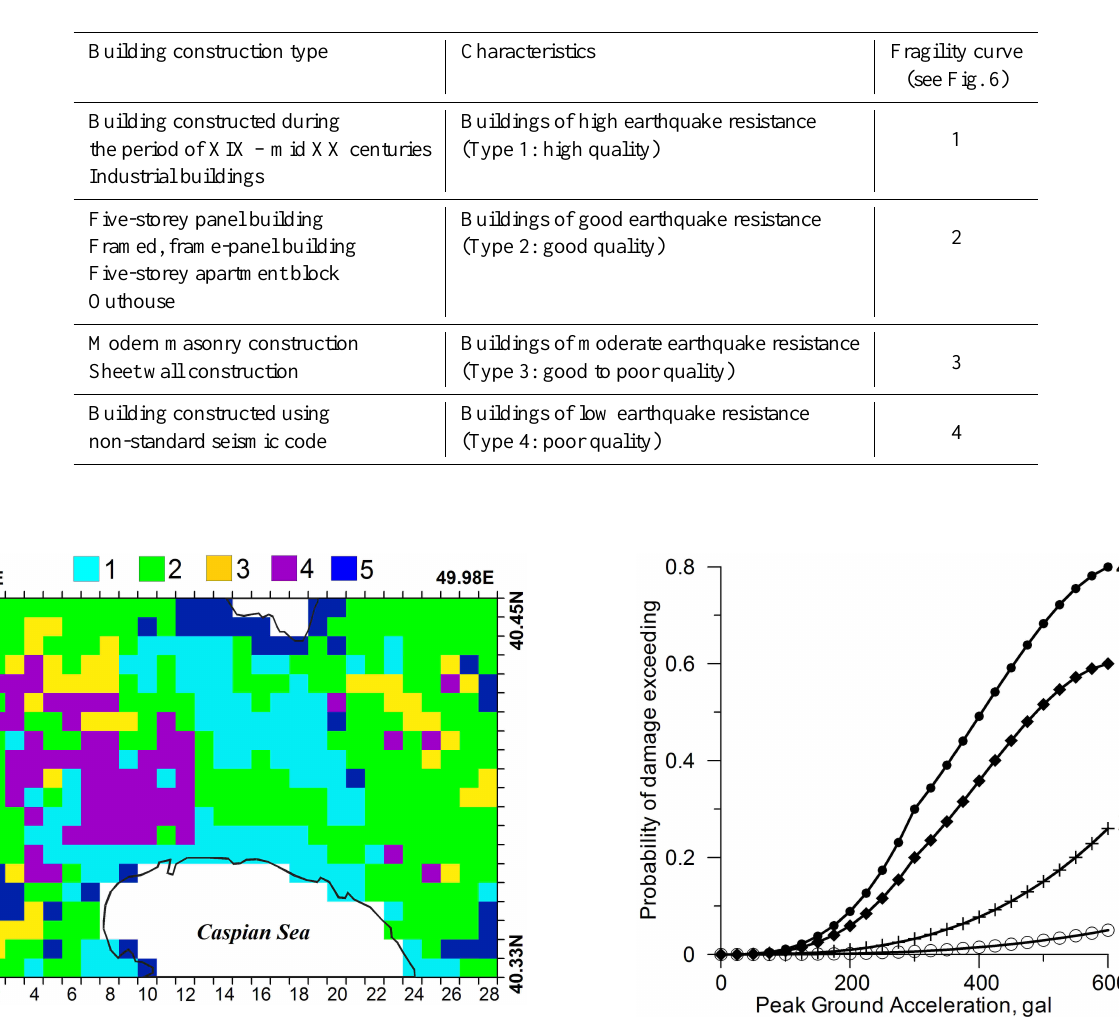
Table 4. Building classification.